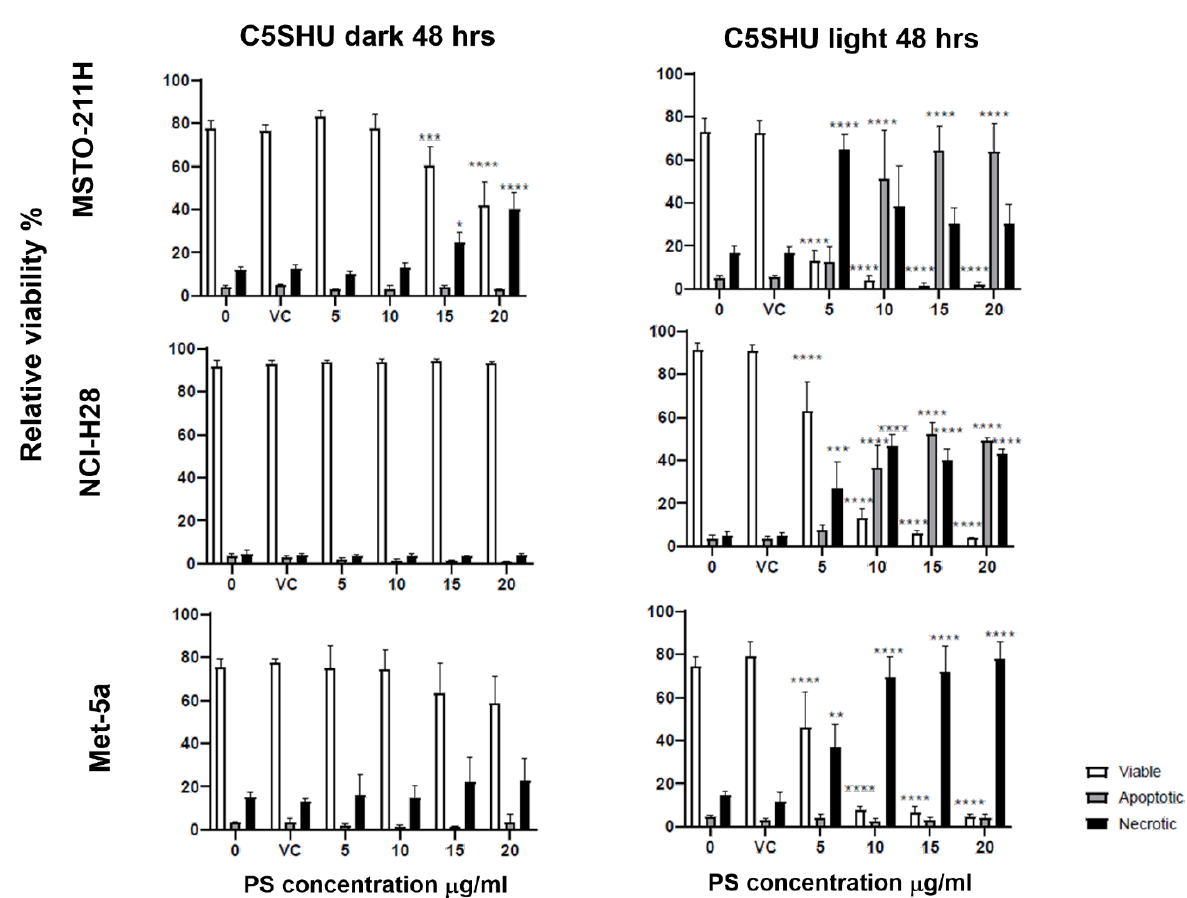
Figure 8. Cell death analysis of C5SHU-treated MSTO-211H, NCI-H28, and Met-5a cells as deter- mined by the Annexin V-FITC/PI assay 48 h after treatment. Results are expressed as the mean ± SD of three independent experiments. The varying significance of viable populations relative to that of the untreated control are indicated by * ( p ≤ 0.05), ** ( p ≤ 0.01), *** ( p ≤ 0.001), and **** ( p ≤ 0.0001). The C6SHU PS did not induce a potent PDT effect in NCI-28 (IC 50 value of >20 µ